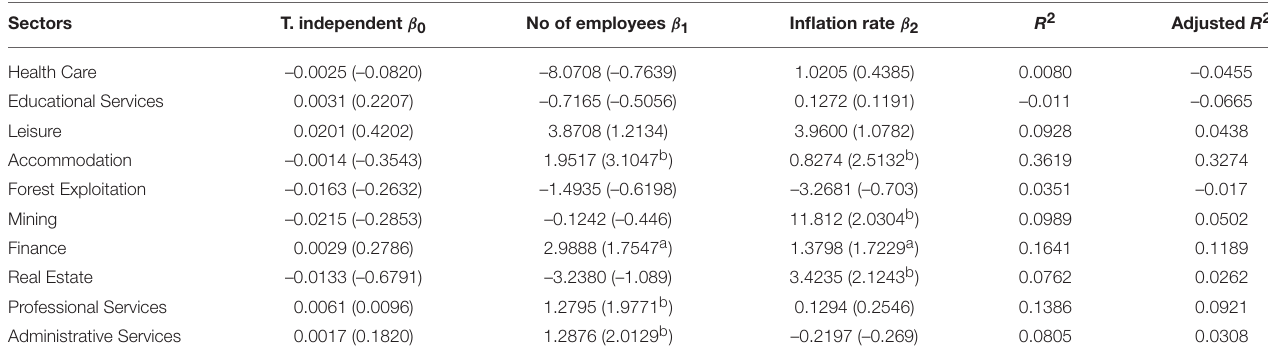
TABLE 4 | Estimation of FT coefficients with the variable “no of employees” for the differentiated sub-sectors. Sectors T. independent β